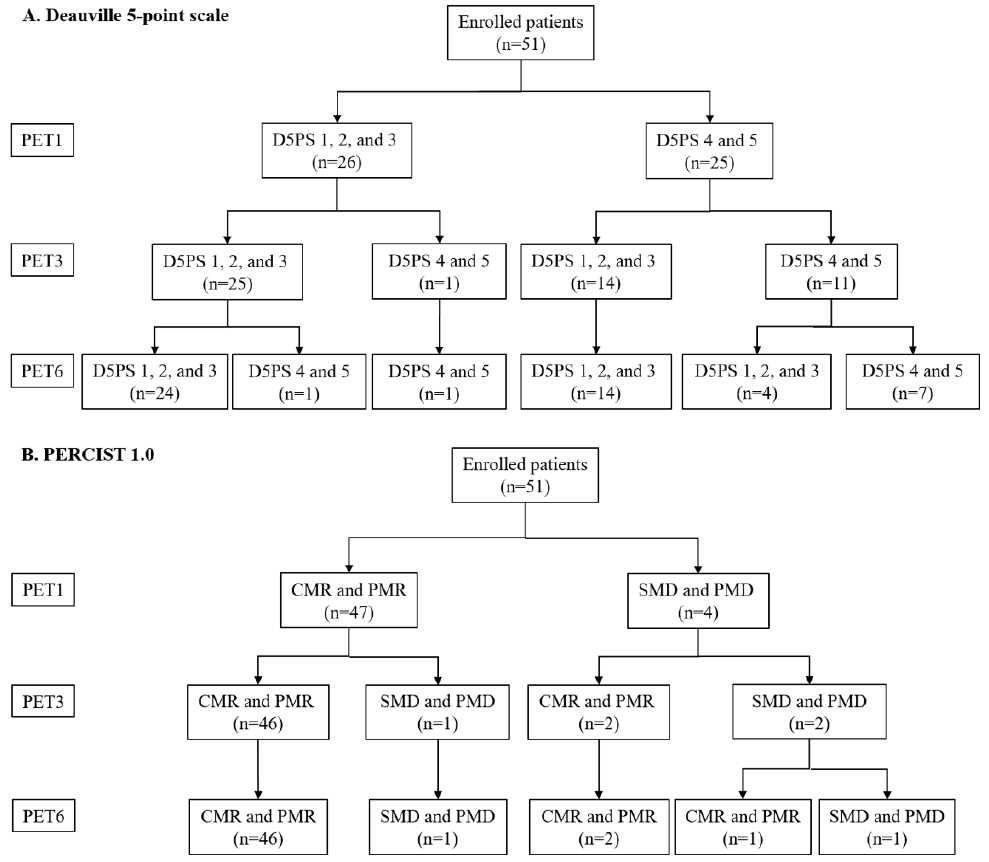
Figure 1. Number of patients according to D5PS ( A ) and PERCIST1.0 response ( B ) at different time points during R-CHOP chemotherapy: early-interim after 1 cycles of chemotherapy (PET1), mid-therapy after 3 cycles of chemotherapy (PET3), and end-of-therapy after 6 cycles of chemotherapy (PET6). Deauville scores of 1, 2 and 3 were grouped to represent complete response ( A ). According to PERCIST1.0, patients showing %ΔSUL ≥ 30% were considered responders; and those with %ΔSUL less than 30% or increase in SULpeak or appearance of new lesion were considered non-responders ( B ).